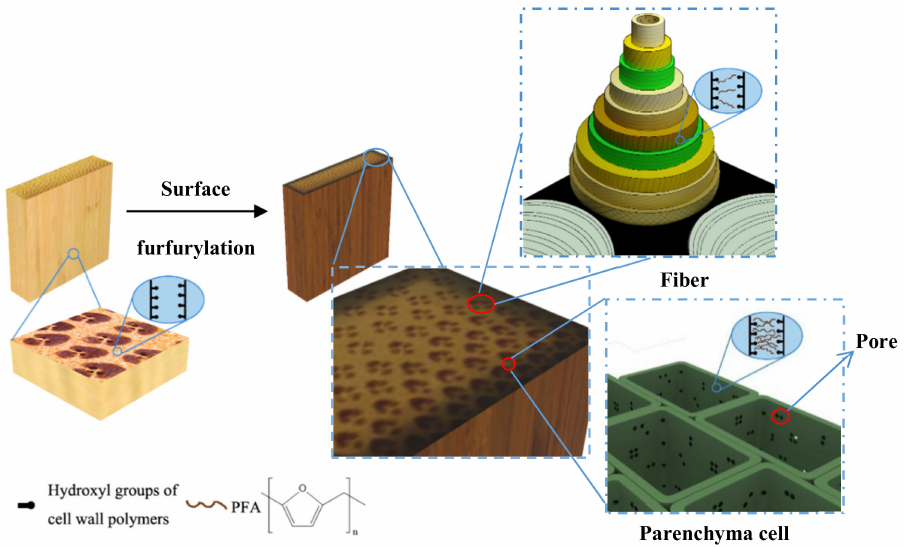
Figure 6. Schematic illustration showing the fabrication process of the surface furfurylated